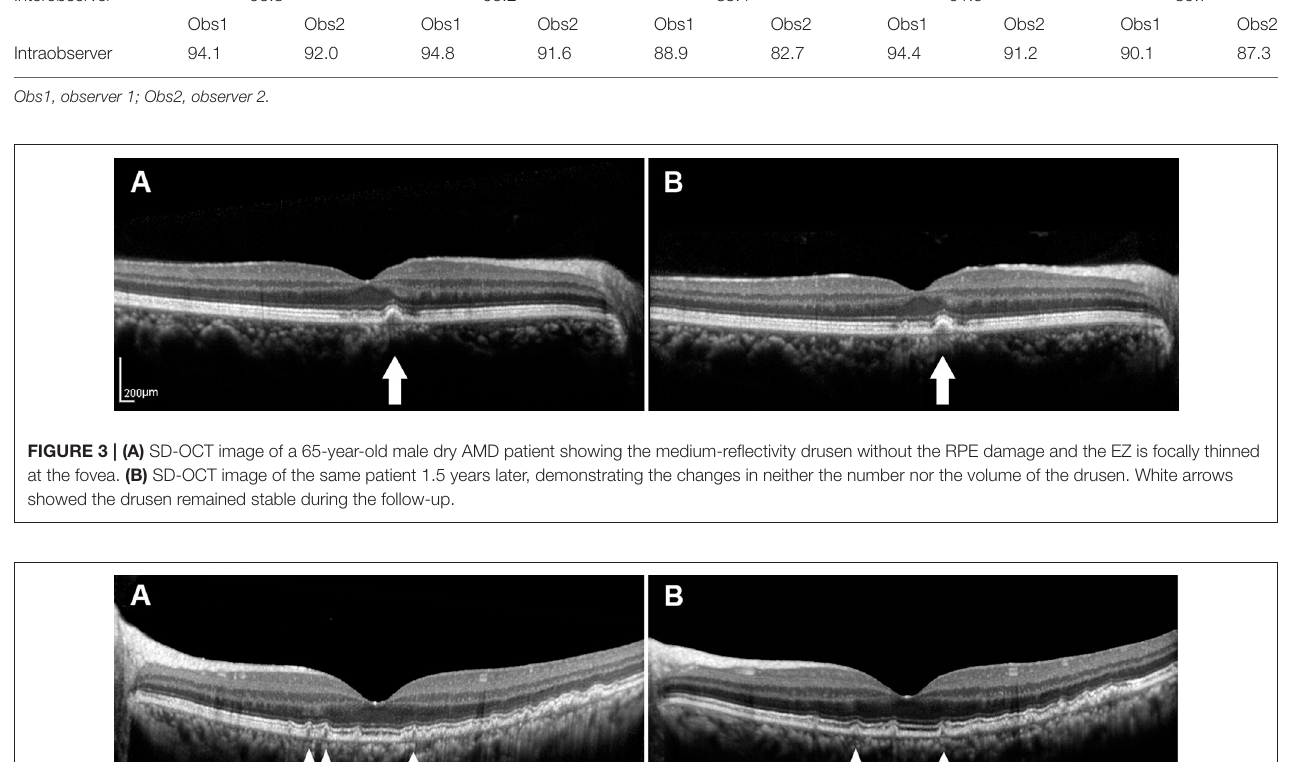
TABLE 3 | Interobserver and intraobserver agreement in the drusen grading of the morphological parameters. Agreement Shape Reflectivity Homogeneity